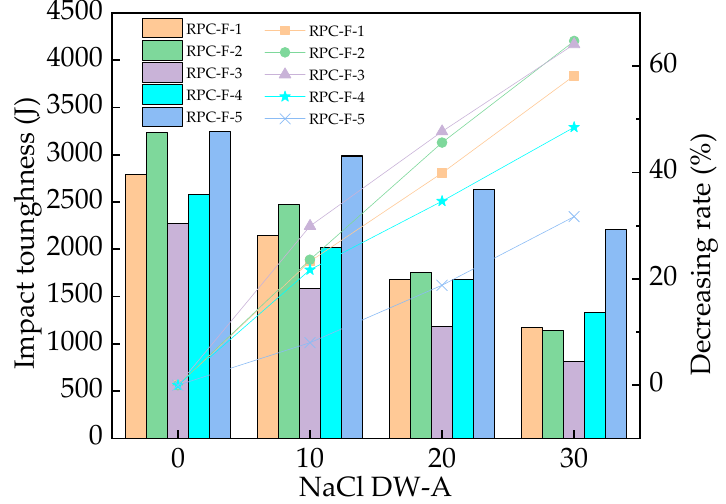
Figure 13. The impact toughness of RPC during NaCl DW-A.